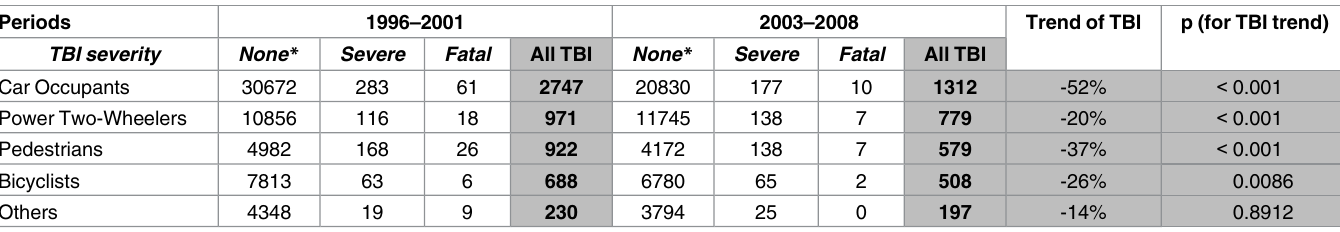
Table 3. Trends of RTC figures and RTC-related TBI regarding their severityamong the different road user types in the observation periods (Vic- tims without injuries encoded in the Registry were removed from the analysis (83 and 50 RTC victims without TBI in both periods respectively; all of these victims died at the scene)